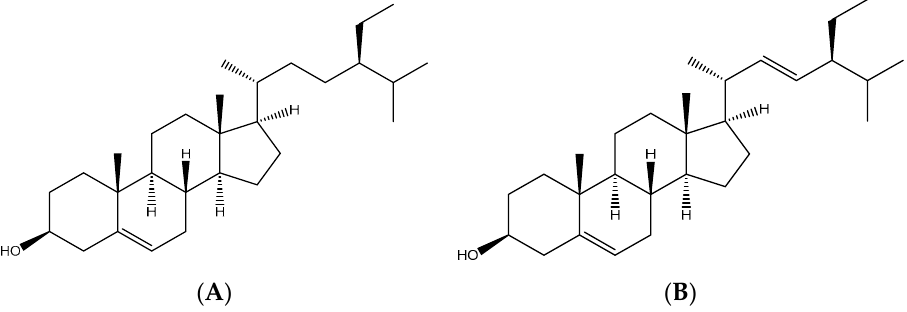
Figure 10. Analysis of chemical constituents of the Ficus awkeotsang Makino extract. ( A ) Structure of β -sitosterol and ( B ) structure of stigmasterol.